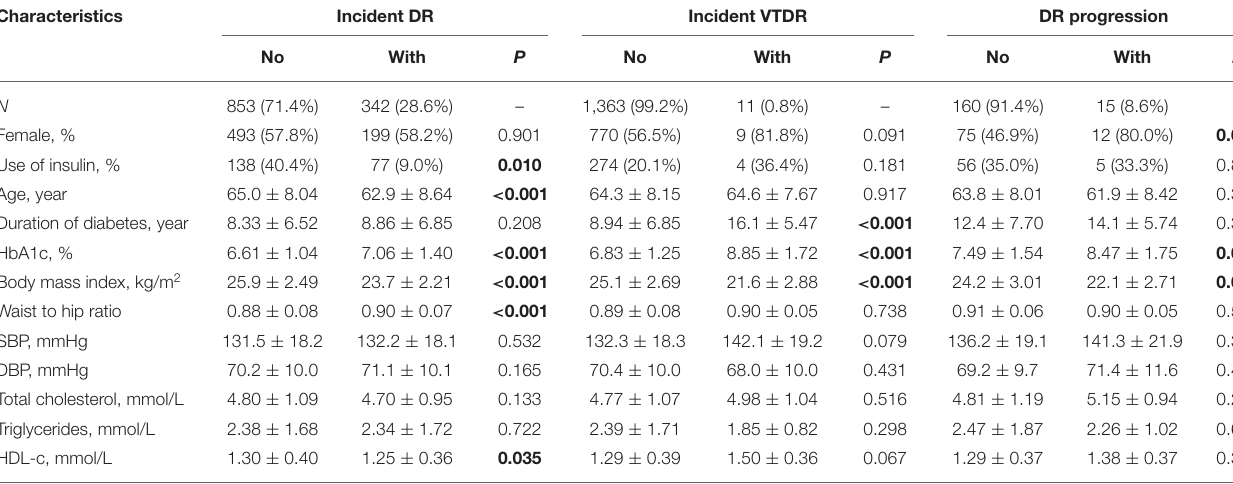
TABLE 1 | Baseline demographic and clinical features of the included participants. Characteristics